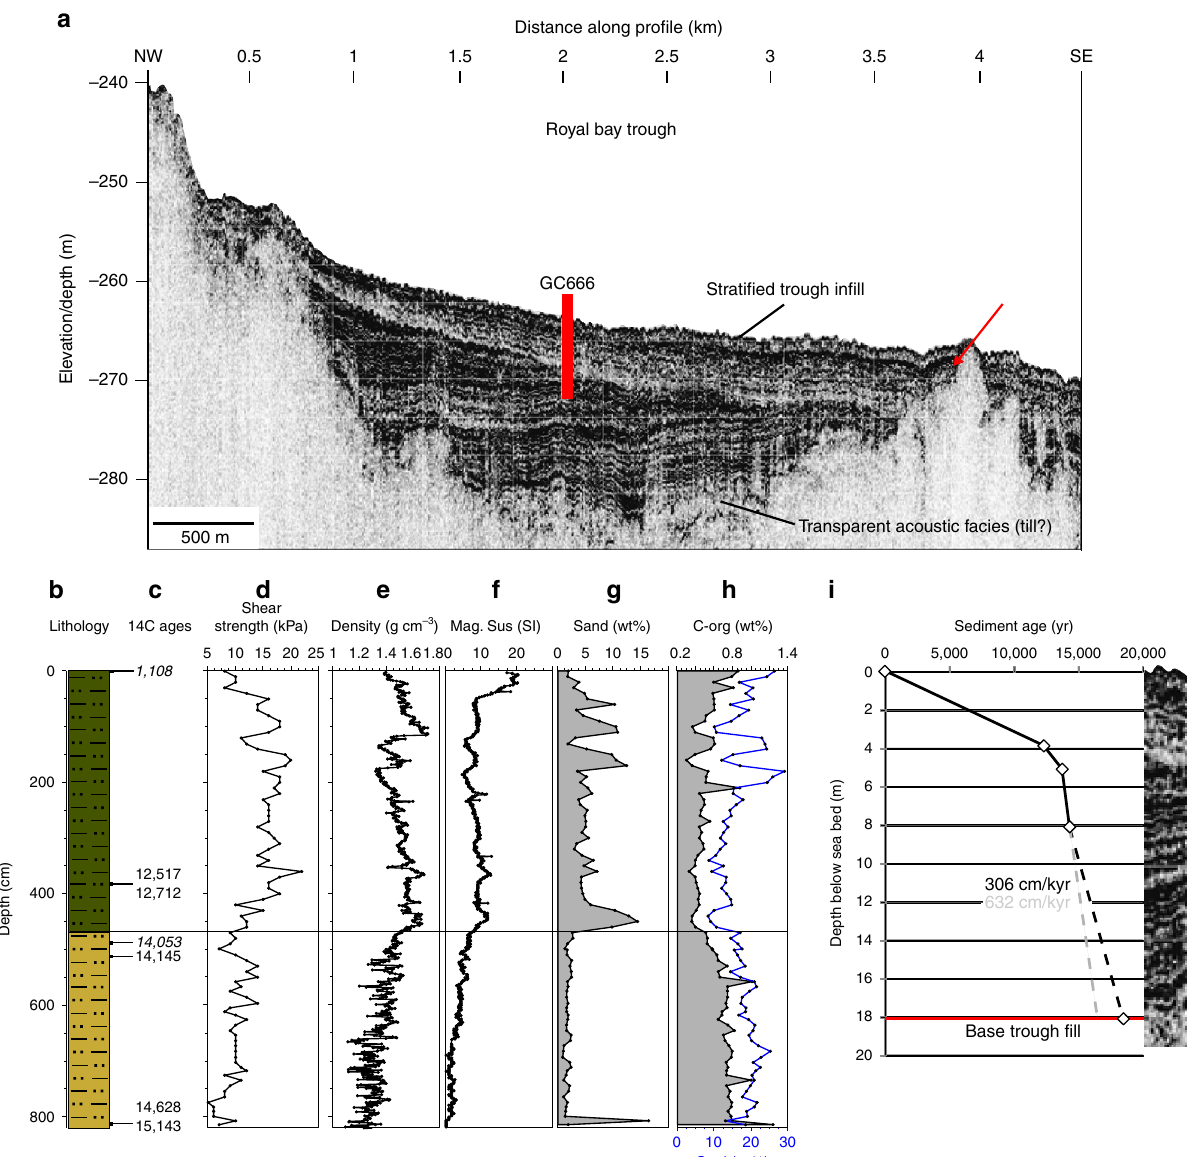
Figure 7 | Characteristics of trough fill sediments in Royal Bay at core site GC666. ( a ) Atlas PARASOUND acoustic sub-bottom profile across the GC666 coring site (red bar). The B 20-m of stratified trough infill onlaps a transparent underlying acoustic facies. At shallow locations the lower units are not represented (for example, red arrow). Core log and properties for gravity core GC666, showing ( b ) simplified lithology, ( c ) AMS 14 C ages (calibrated yr), ( d ) shear strength, ( e ) density, ( f ) magnetic susceptibility, ( g ) percentage sand content, ( h ) total organic carbon and biogenic opal content. ( i ) Age-depth model for the core showing the change in sedimentation rates at the boundary between lithological units I and II and down-section extrapolations to predict the timing of onset of trough infill, based on correlation to the PARASOUND profiles. Velocity used for correlation 1,500ms (cid:2) 1 . Note that the reported age at 490cm is an average of two radiocarbon measurements, while the age at 510cm uses the older of two measurements at that horizon. Core top is assumed modern (conventional 14C age